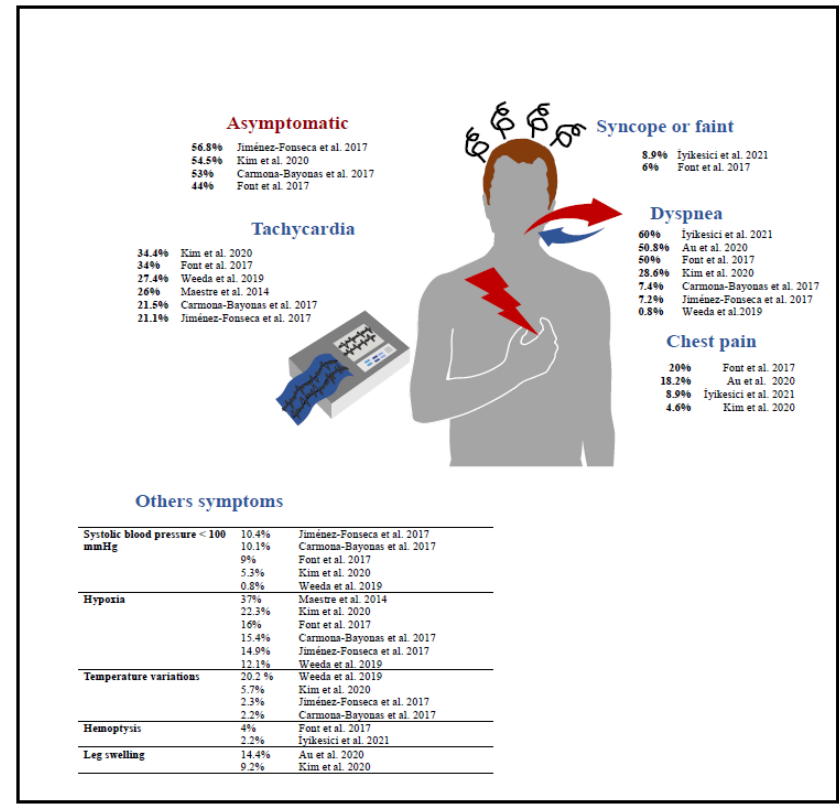
Figure 3. Repartition of the symptoms in cancer-related PE [5,6,10–12,15,16,22]. To improve the diagnosis of low-probability PE, clinical prediction rules have been de- veloped. Clinicians rely on prediction rules such as the Wells or Geneva rules. These rules incorporate plasma D-dimer measurements, which are recommended in outpa- tients/emergency department patients with a low or intermediate clinical probability or those that are PE-unlikely. In these same prediction rules, cancer is already a predictor that increases the likelihood that patients will undergo a redundant computed tomography pulmonary angiogram (CTPA) for PE and will not be tested for D-dimer levels [46,47]. Making use of different methods to test D-dimer levels demonstrated that cancer patients have a higher D-dimer concentration, regardless of the presence of VTE [48]. This results in a lower specificity of D-dimer tests in cancer patients [49]. Following the recommendations of the ADJUST-PE study, the age-adjusted increased cutoff for D-dimer interpretation in the general VTE population became the standard [50]. In 2017, Wilts et al. performed an analysis of the cancer patients included in the ADJUST-PE study [51]. Here it was shown that the age-adjusted D-dimer cutoff decreased the need of performing CTPA to rule out PE in cancer patients (9.9% CTPA with the age-adjusted cutoff vs. 19.7% CTPA with the conventional cutoff 0.5 µ g/mL, out of 429 included cancer patients, p < 0.001). Nowadays, the age-adjusted D-dimer is the standard also in cancer patients. YEARS is a newly